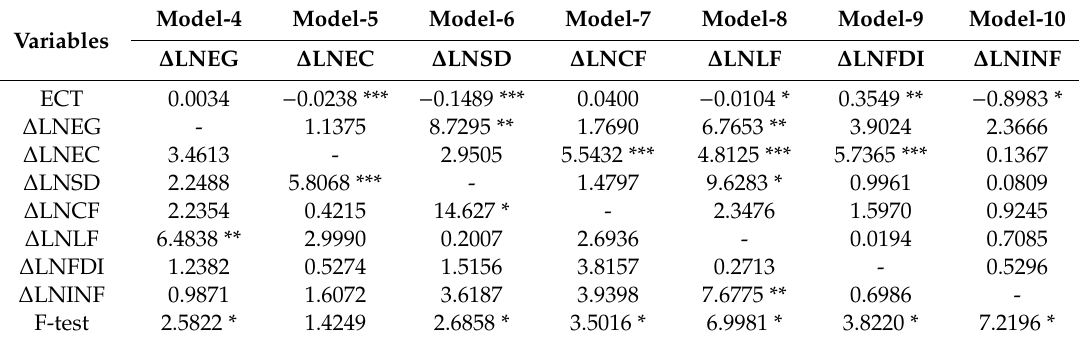
Table 6. Panel Vector Error Correction Model (VECM) for the Model